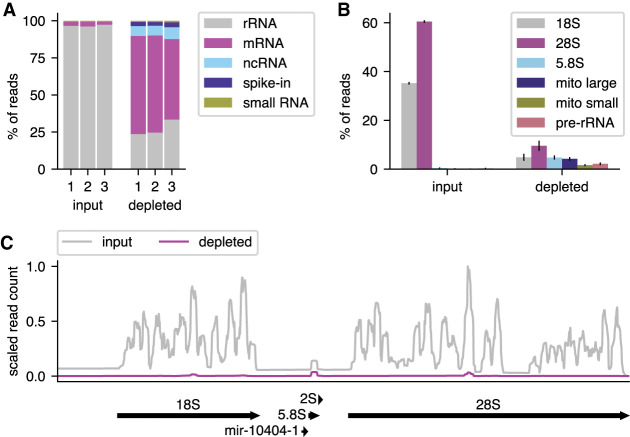
Ribo-Pop drastically increases effective sequencing depth. The effectiveness of Ribo-Pop depletion was assessed by RNA sequencing of input and depleted libraries prepared from Drosophila larval RNA. (A) The percent of reads assigned to each transcript class (biotype), is plotted for each of the three replicates of the input and depleted RNA samples. The data were obtained from three independent RNA samples in which each sample was used to construct one input library and one depleted library. (B) The percent of reads assigned to each type of ribosomal RNA is shown for the input and depleted samples. Error bars represent standard deviation between the three replicates. (C) RNA-seq coverage of a representative pre-rRNA locus (FBgn0267507) and its cleavage products in input and depleted samples. Reads in each library were scaled by the synthetic spike-in counts to allow direct comparisons between libraries. The average of three replicates for each sample type is plotted.